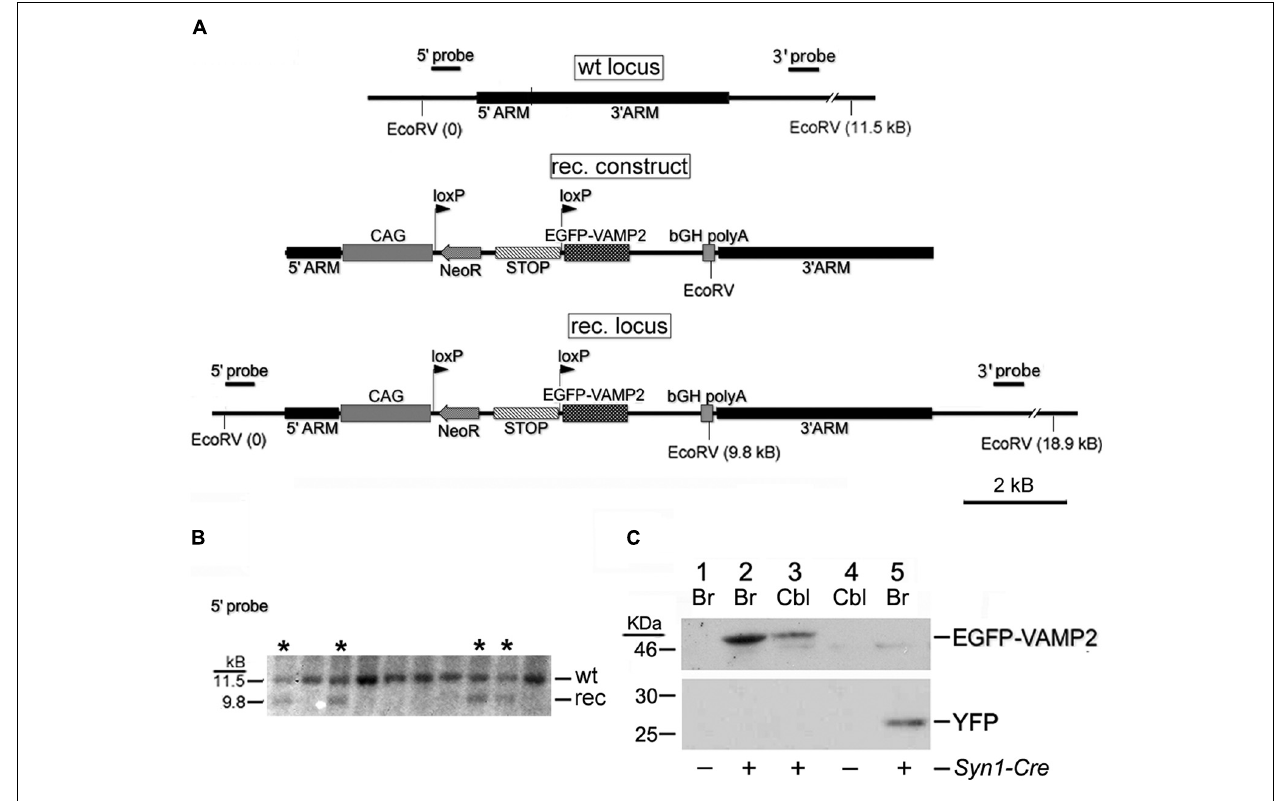
FIGURE 1 | Generation of the Rosa26 EGFP-VAMP2 line. (A) Schematic representation of the wt Rosa26 locus, recombinant (rec.) construct and rec. locus obtained by homologous recombination within the 5 (cid:2) and 3 (cid:2) homology arms. See Section “Results” for a description of the rec. construct. CAG, chicken β -actin promoter and CMV enhancer. bGH, bovine growth hormone. (B) Southern analysis of ES cell clones using the 5 (cid:2) probe sketched in (A) . Lanes marked by asterisks (*) correspond to recombinant